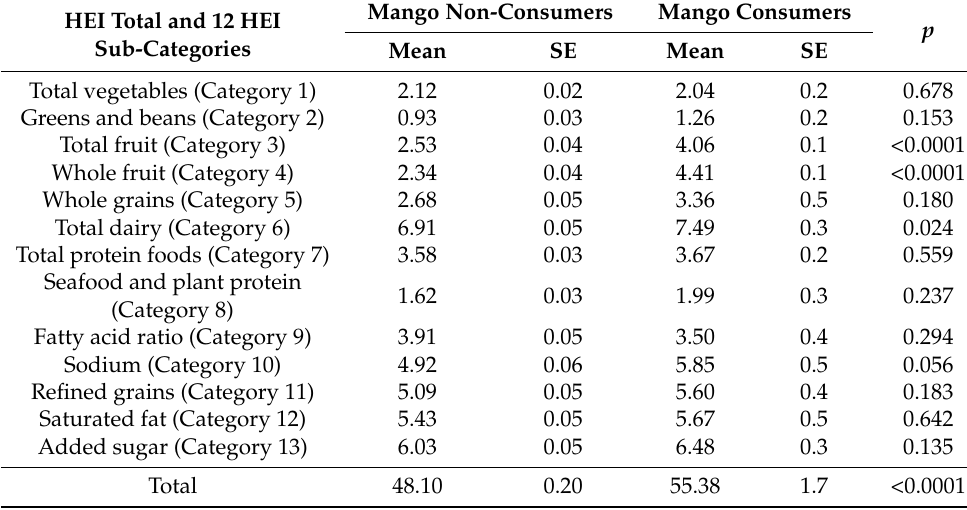
Table 4. Day 1 Healthy Eating Index (HEI)-2015 and sub-category mean scores in children.